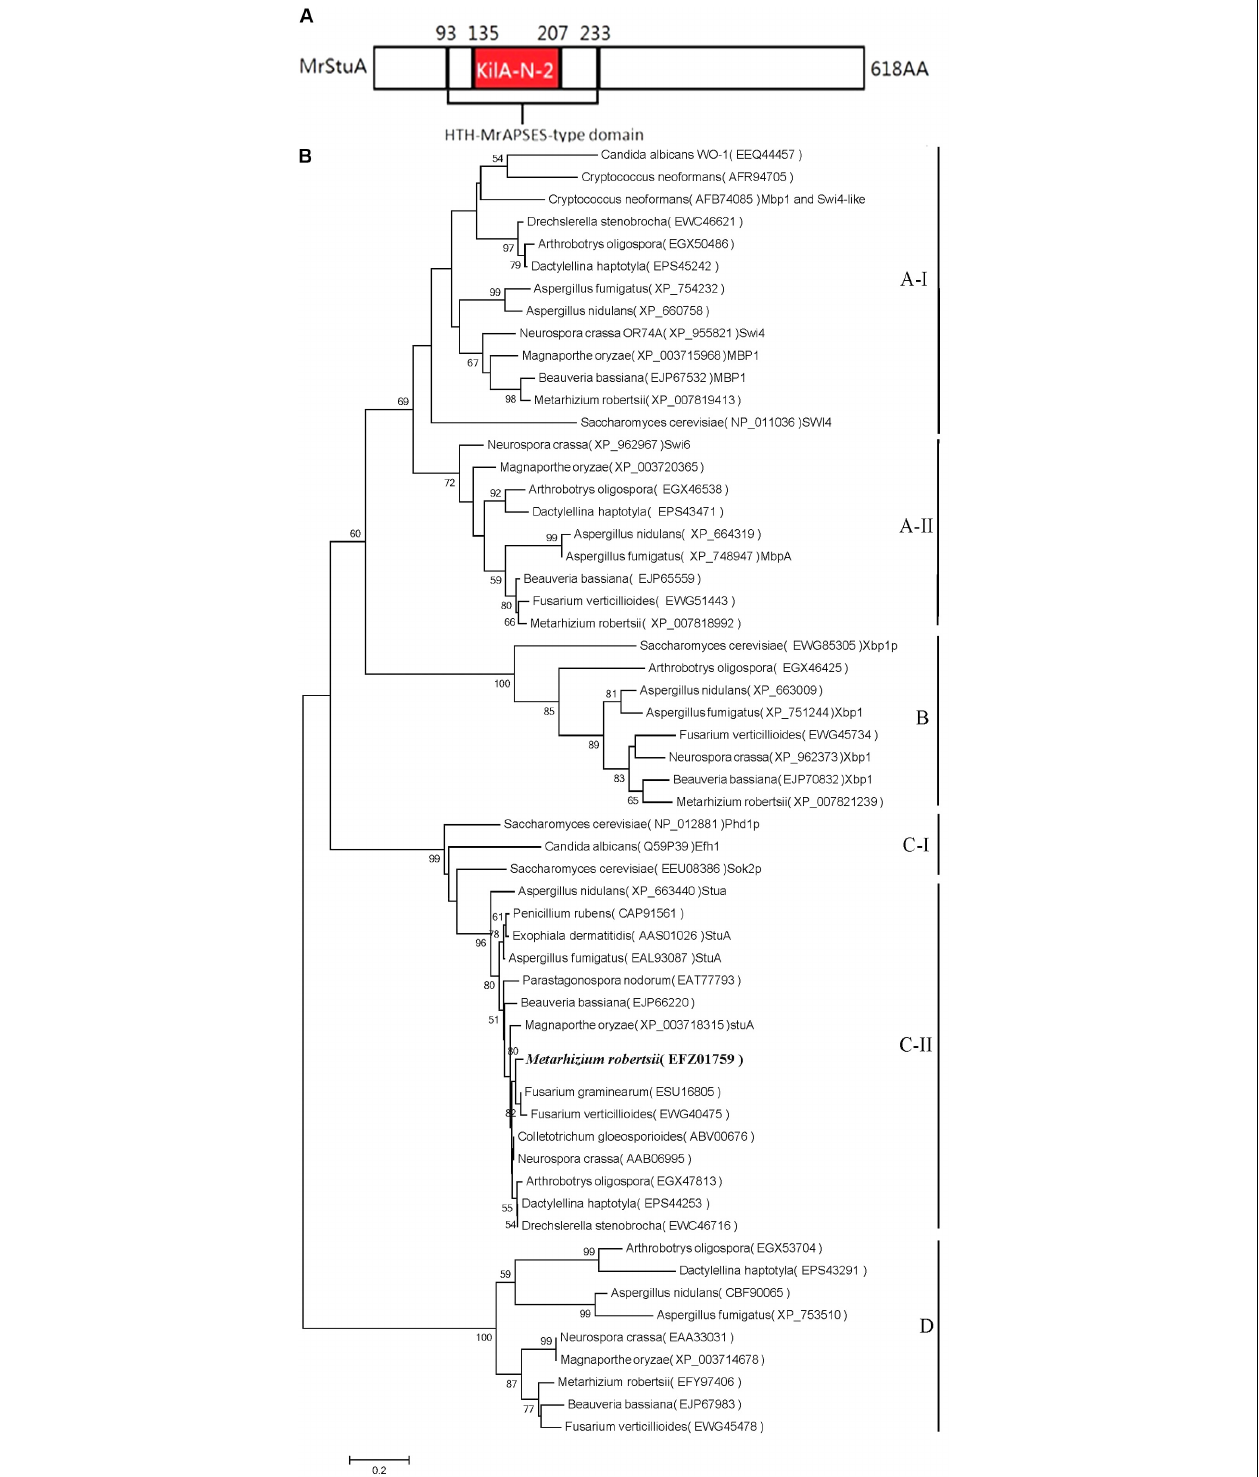
Frontiers in Microbiology |